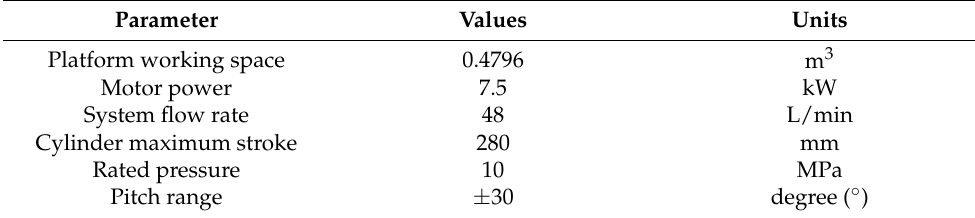
Figure 4. Dry test workflow. Table 3. Supporting test parameters of the dry test